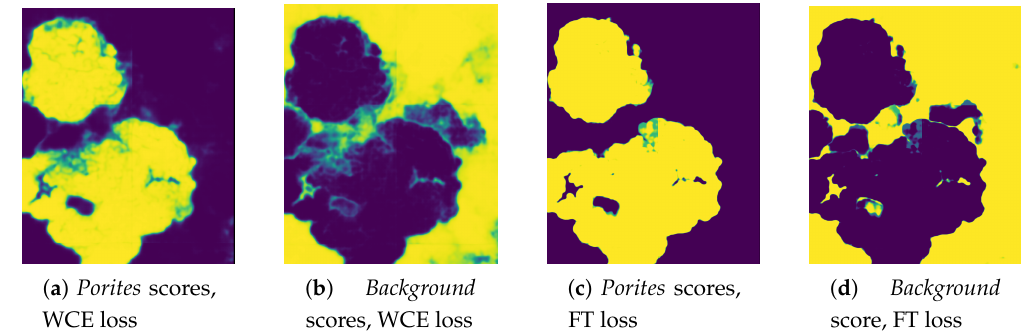
Figure 5. CNN scores for the Porites and Background classes: high probabilities are colored in yellow, low in purple, mid values in green-blue. As visible, the model optimized minimizing the FT exhibits less uncertain